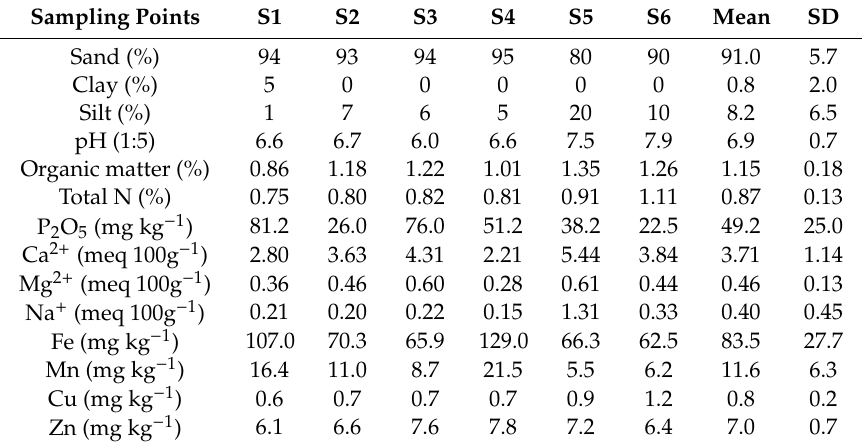
Figure 5. Soil apparent electrical conductivity (EC a ) maps of “Eucalyptus” field in April 2017: at 0 – 0.5 m ( a ) and 0 – 1.0 m ( b ). Table 2. Soil characteristics of the “Eucalyptus” field at 0–0.30 m depth.